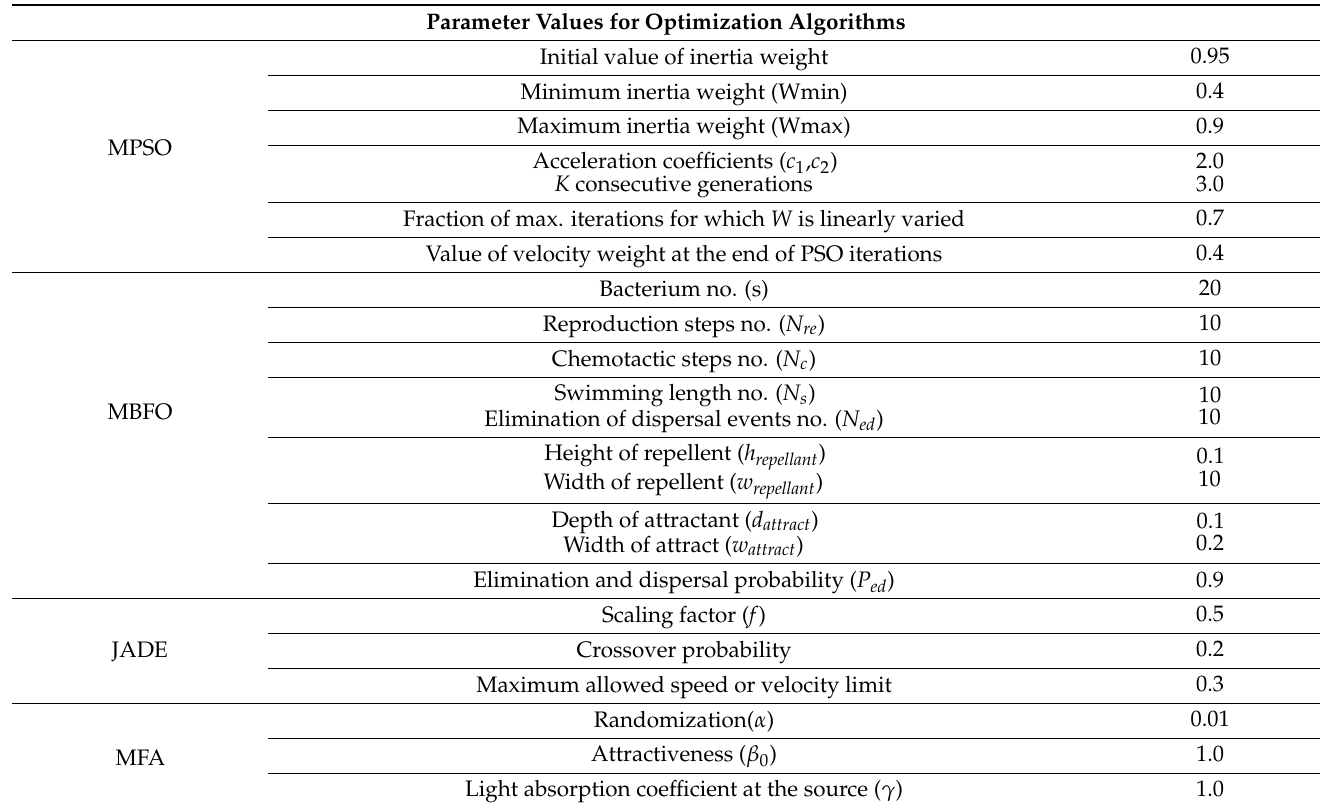
Figure 1. Original test images ( a ) Test image 1, ( b ) Test image 2, ( c ) Test image 3, ( d ) Test image 4, ( e ) Test image 5. Table 1. Parameter values for optimization